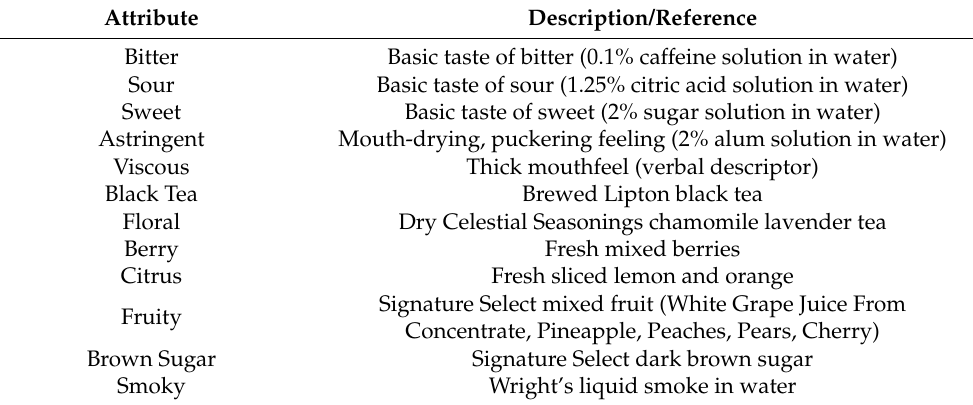
Table 2. Sensory attributes chosen for the study and corresponding reference standards prepared for the